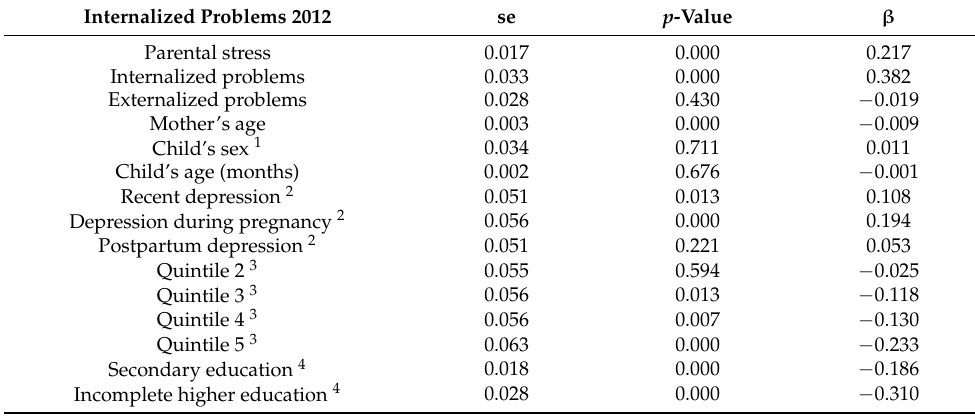
Table 7. Set of predictors of internalized